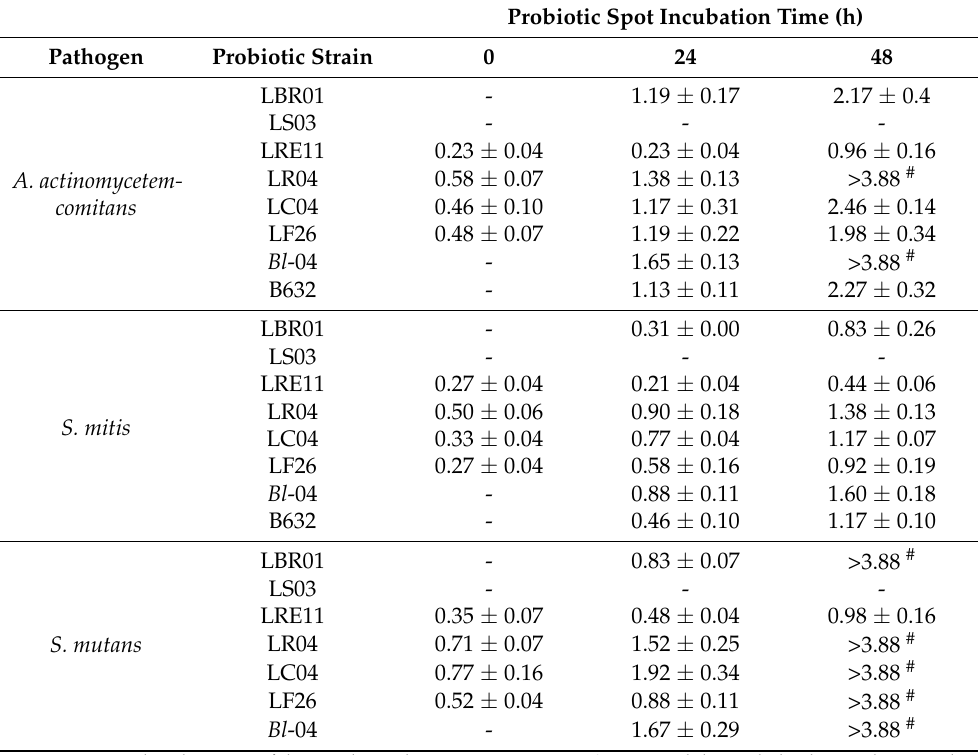
Table 1. Normalized width measurement in mm of inhibition halos obtained in the agar spot